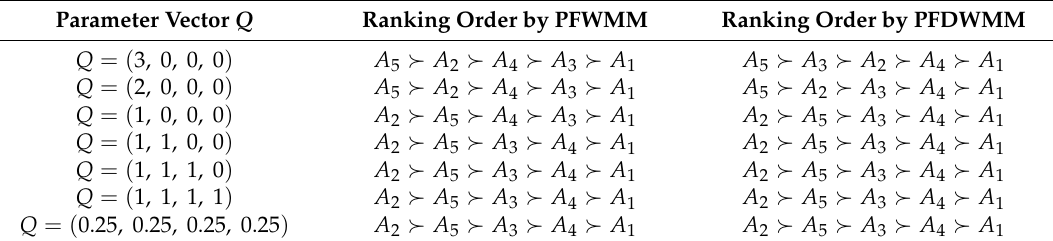
Table 12. Ranking order of alternatives determined by different parameter vector Q .